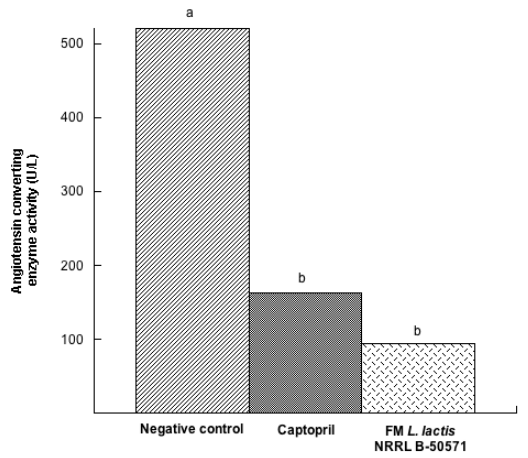
Figure 5. Angiotensin converting enzyme activity (U/L) in plasma from spontaneously hypertensive rats after long-term treatments. Negative control: purified water; Captopril: 40 mg/kg body weight; FM L. lactis NRRL B-50571 (ad libitum): fermented milk with L. lactis NRRL B-50571. Data are